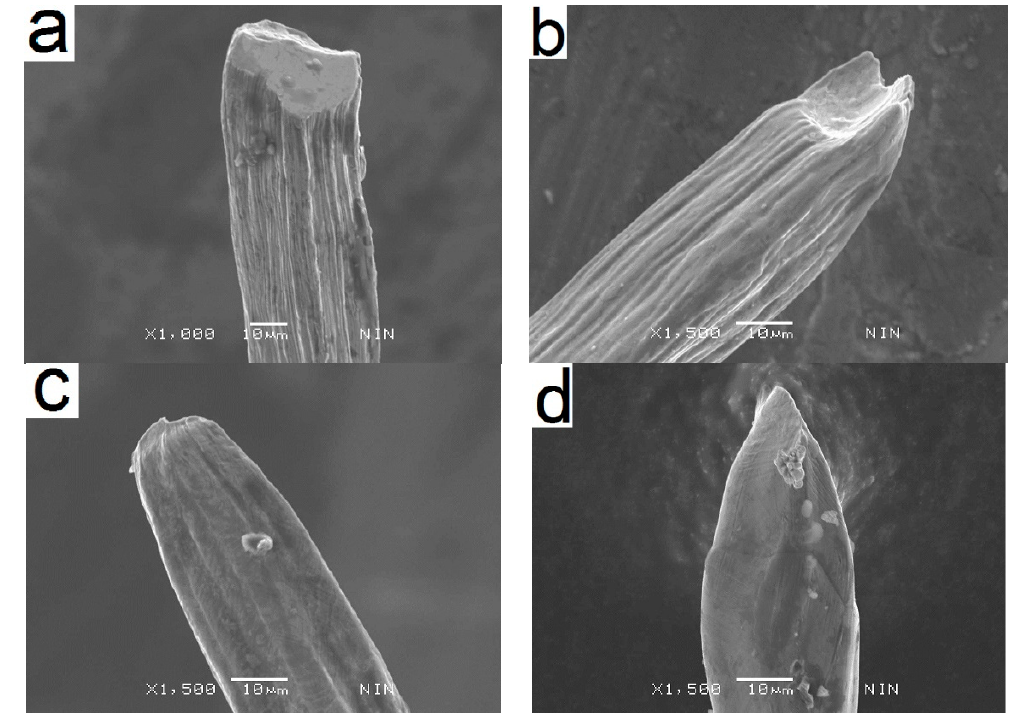
Figure 6. Fracture surfaces of single fiber of ( a ) as drawn; ( b ) sample I; ( c ) sample II; ( d ) sample VII.